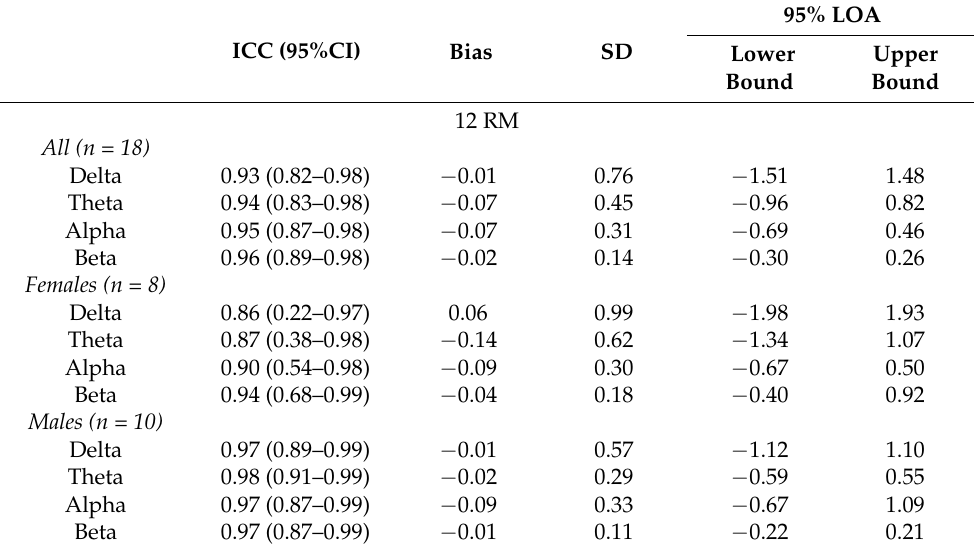
Table 2. Inter-day repeatability statistics during 12 RM exercise condition.